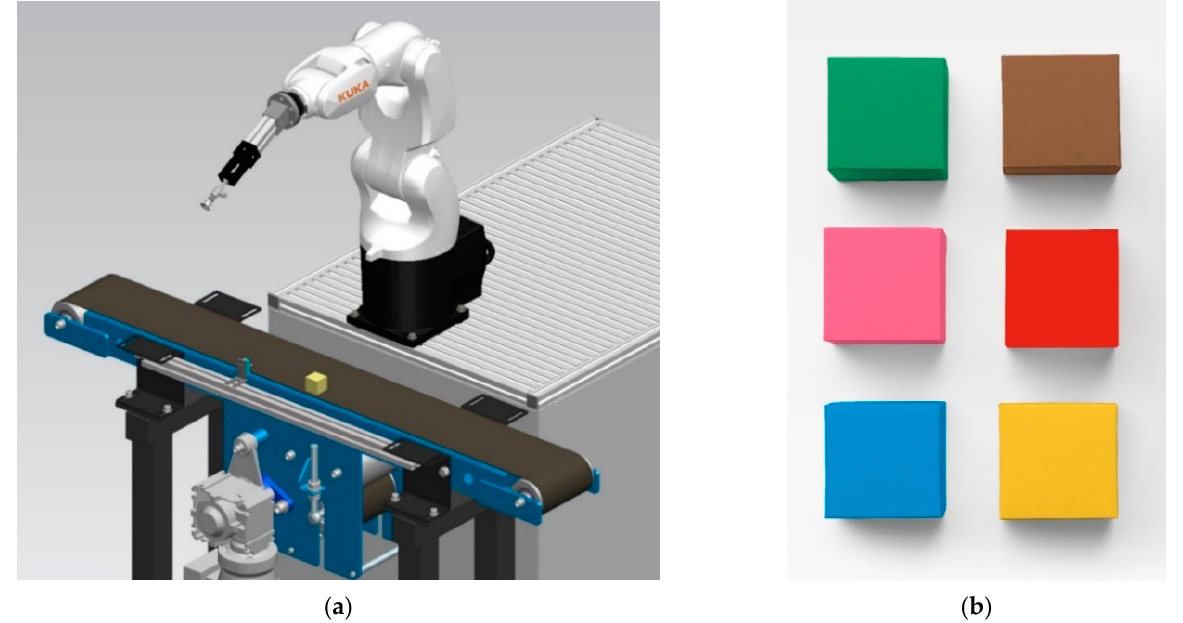
Figure 1. ( a ) Design of test robotic workplace in the Siemens Tecnomatix Process Simulate environment; ( b ) Calibration cubes for simulation of six different customized products.